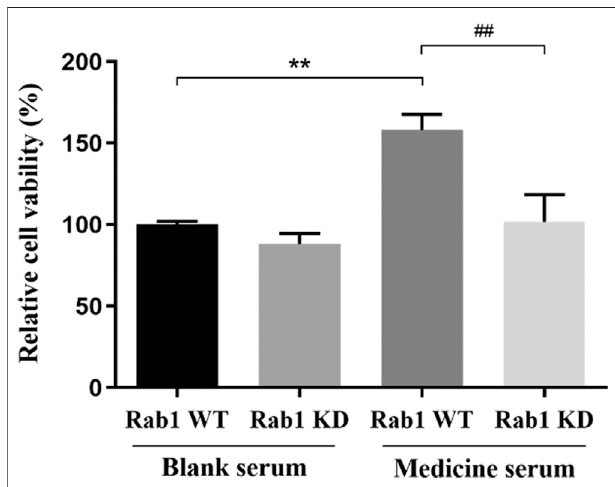
FIGURE 10 | Effect of FYXN serum on the proliferation of BMECs, ** p < 0.01 compared with NC + Rab1WT group; ## p < 0.01 compared with the FYXN + Rab1WT group.